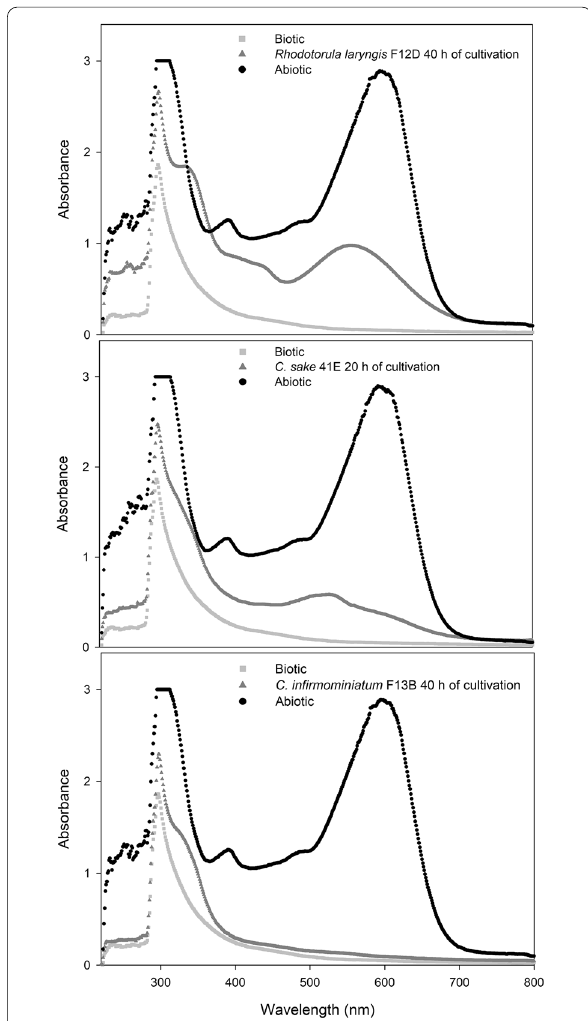
Fig. 2 UV–visible scans from batch cultures of Rhodotorula laryngis , Candida sake , and Cystofilobasidium infirmominiatum containing 100 mg L –1 of Reactive Black 5 at different incubation times. The three spectra illustrate the decrease in absorbance of the dye obtained from the starting abiotic control (situation without yeast, black line, top record) to that occurring after incubation with the yeast (dark-gray line, middle record), compared to the spectrum of the biotic control (situation in the absence of dye, light-gray line, bottom